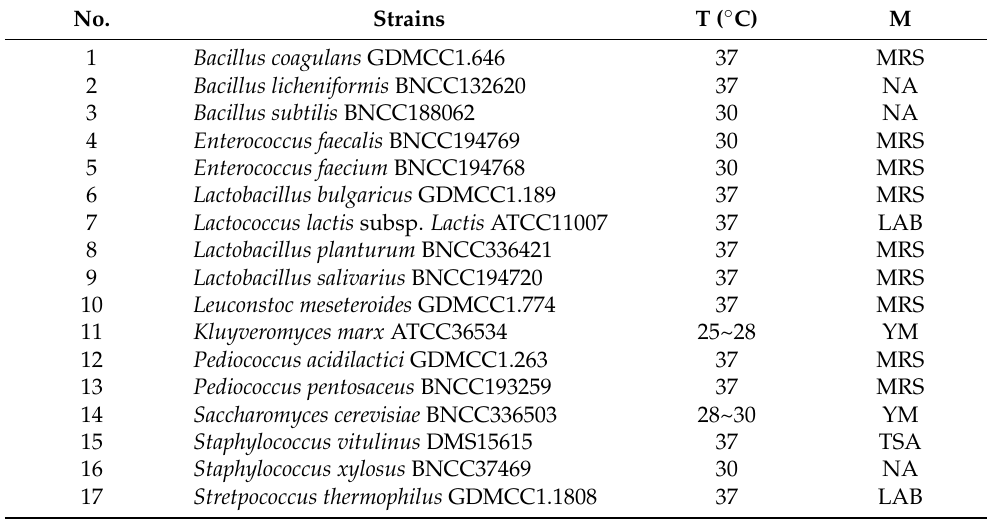
Table 2. The list for gut microbe strains and their cultural temperatures (T) and media